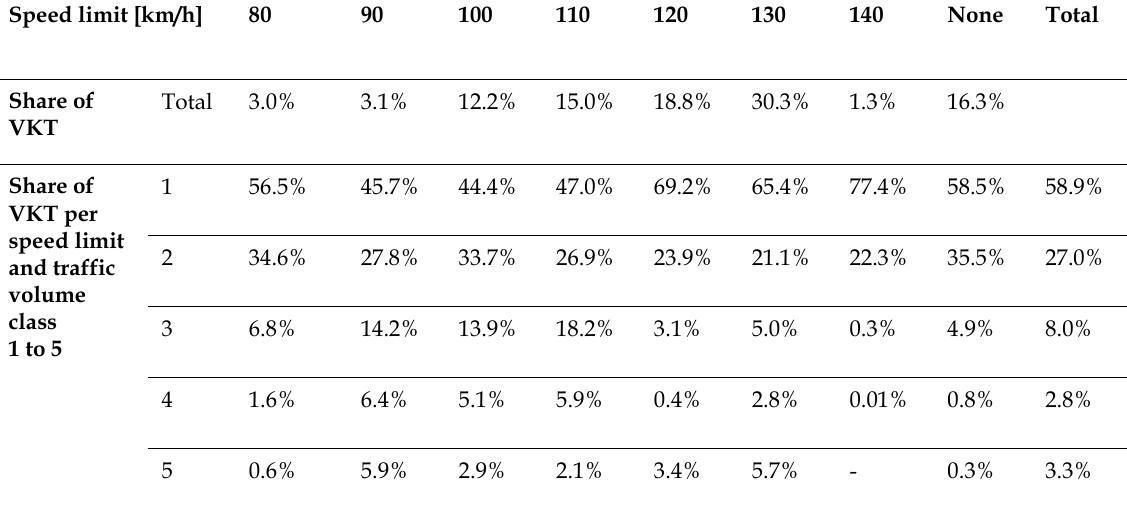
Distribution of VKT in EU27+3 per speed limit and traffic volume class. Volume